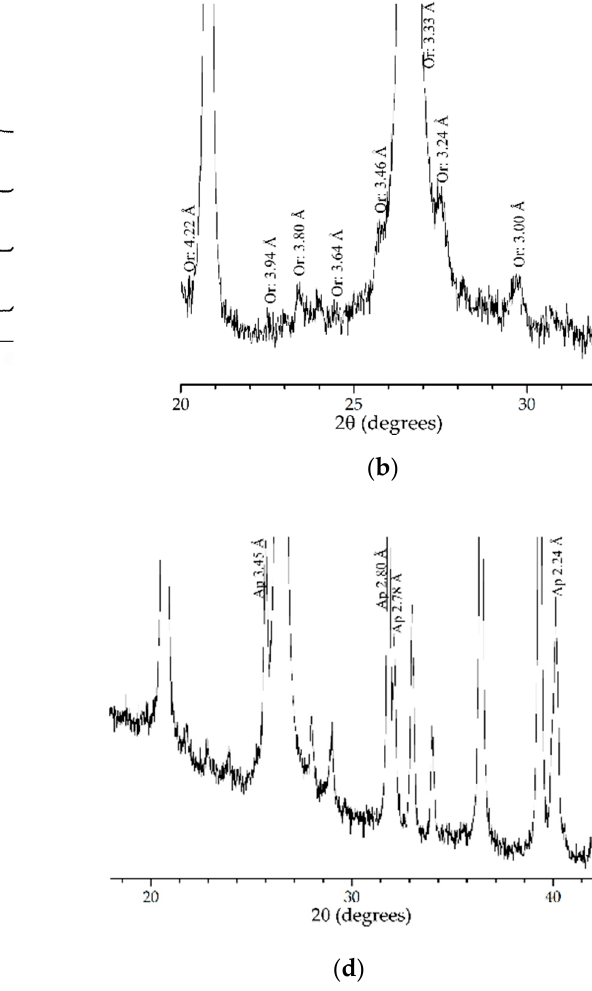
Figure 5. X-ray diffraction patterns of the chert samples from coastal outcrops showing reflections of quartz, Qz, and calcite, Cal, and calcite ( a ); orthoclase, Or, ( b ); moganite, Mog, ( c ) and fluorapatite, Ap, ( d ).